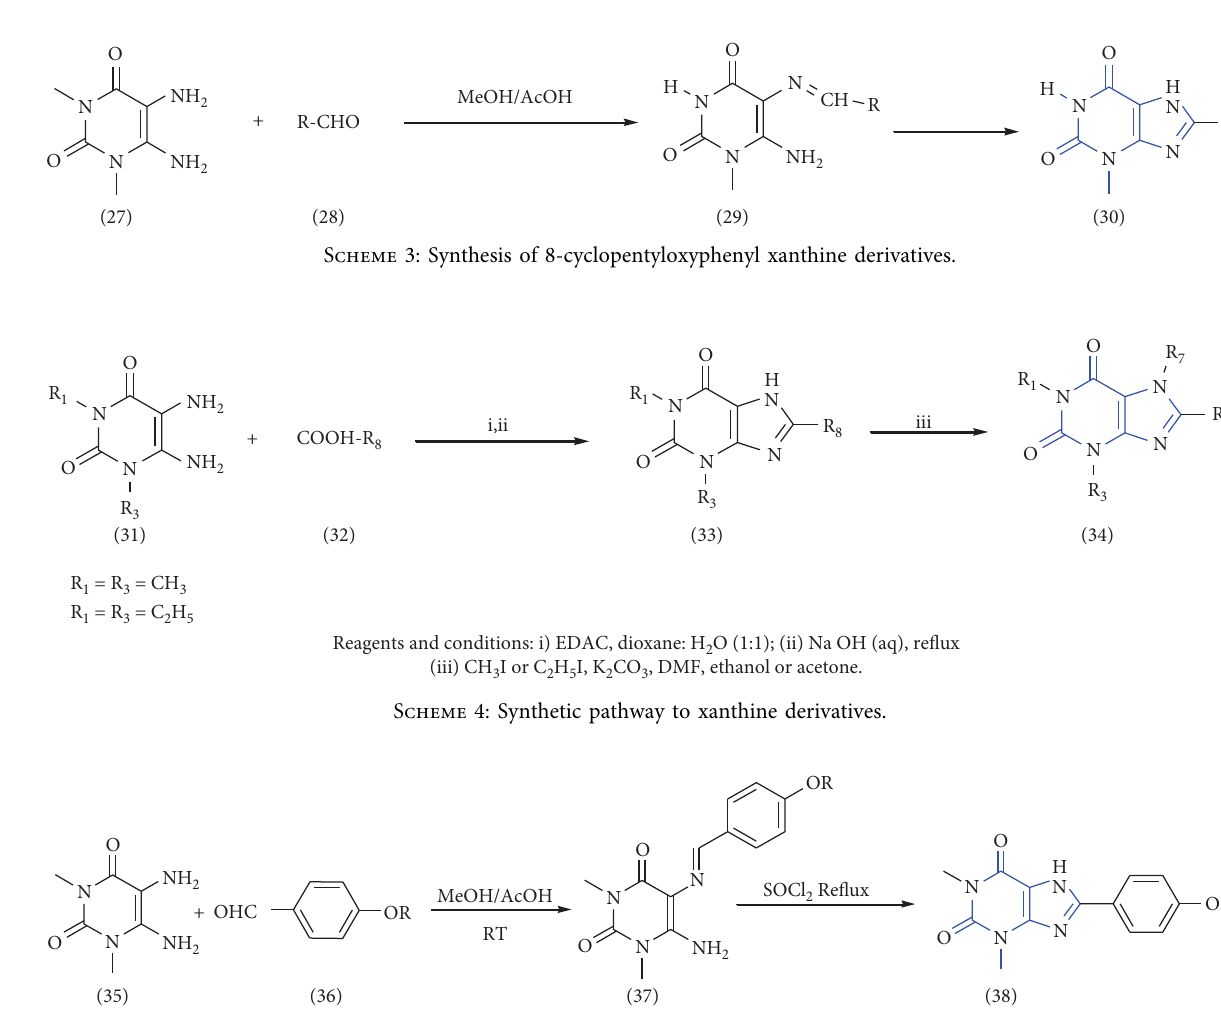
Scheme 5: Synthesis of 8-(p-substituted) xanthine